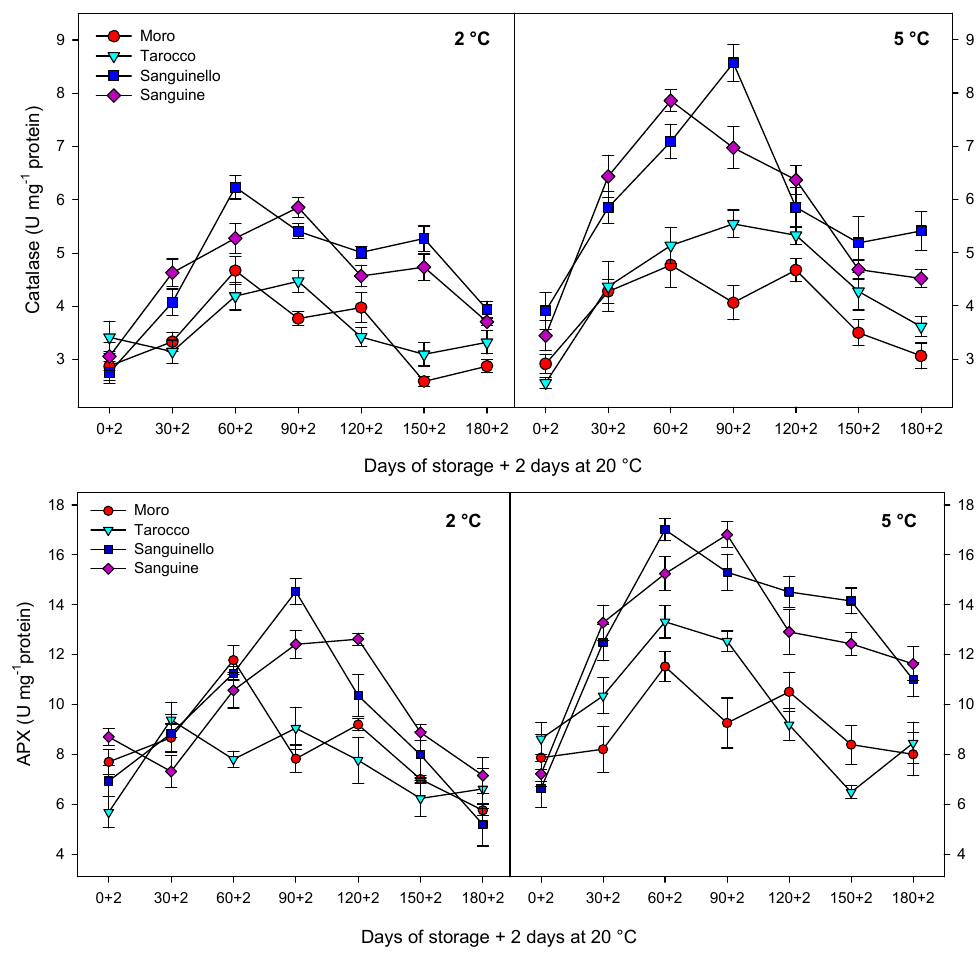
Figure 4. Changes in catalase (CAT) and ascorbate peroxidase (APX) enzyme activities in the flavedo of blood orange cultivars (‘Moro’, ‘Tarocco’, ‘Sanguinello’ and ‘Sanguine’) during cold storage at 2 and 5 °C and 90% relative humidity (RH) plus 2 days at 20 °C. Vertical bars represent ± standard error (SE) of means. LSD ( p < 0.05) value is 1.10 for CAT and 2.31 for APX. SOD activity of cultivars was affected at both temperatures during storage (Figure 5). ‘Moro’ and ‘Tarocco’ had the lowest SOD activity at 5 °C. However, the highest SOD activity was found in ‘Sanguinello’ and ‘Sanguine’ without significant differences. As shown in Figure 5, SOD activity sharply increased for all cultivars up to 60 days of storage at 5 °C and then decreased to the end of storage. This trend was similar at 2 °C; however, SOD activity slightly increased in ‘Tarocco’ and ‘Sanguinello’ at the end of storage.